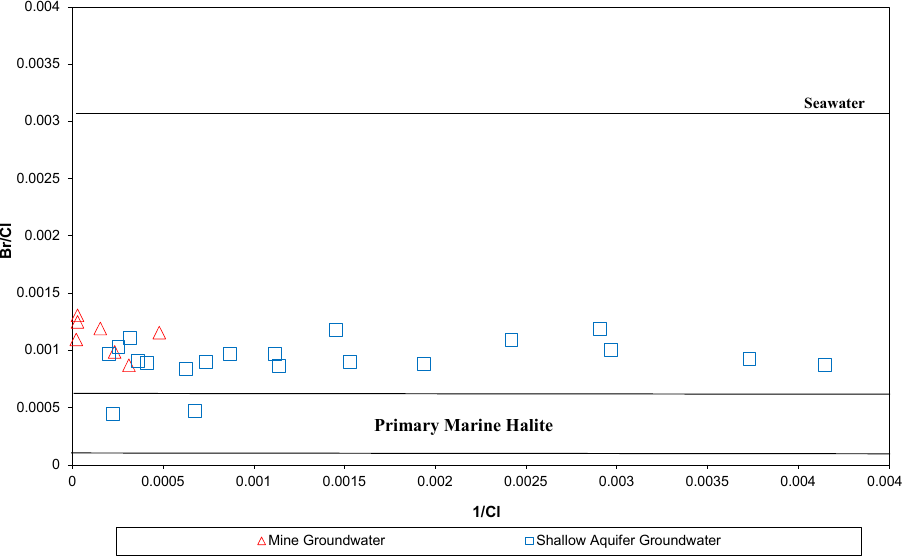
Figure 5. Plot of Na + /Cl − (meq/meq) versus 1/Cl − of shallow aquifer and mine groundwater. The relationship between the Br − /Cl − ratio and 1/Cl − (Figure 6) shows that almost all the Br/Cl ratios of the groundwater samples are between those of seawater and those of primary marine halite. However, as with the Na + /Cl − ratio, two distinct behaviors are ob ‐ served. The Br − /Cl − ratio of mine groundwater is high in saline groundwater and decreases towards groundwater with lower chloride concentrations. While in the groundwater of the shallow aquifer, all samples show a slightly higher Br − /Cl − ratio than the primary ma ‐ rine halite, this ratio remains almost constant and independent of the chloride concentra ‐ tion except for two samples with primary marine halite ratios.